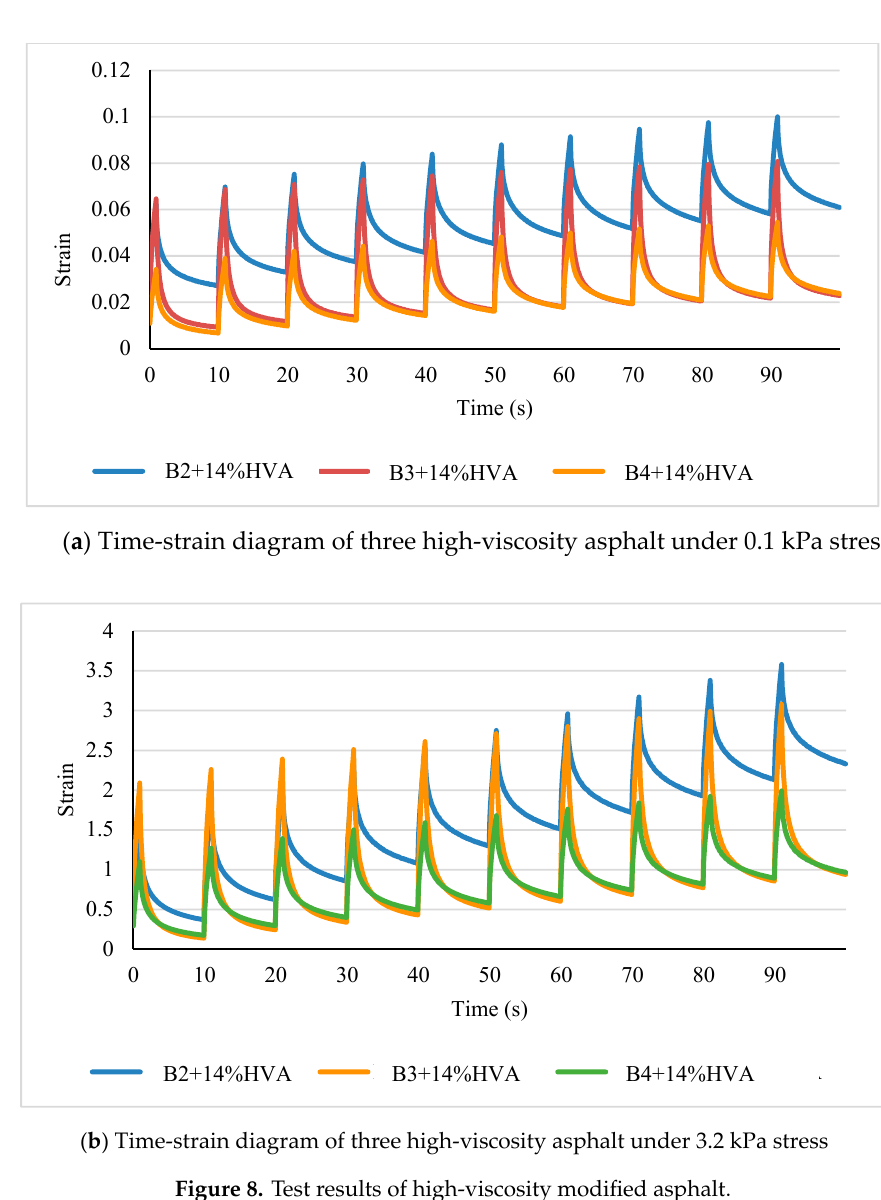
Figure 8. Test results of high-viscosity modified asphalt.